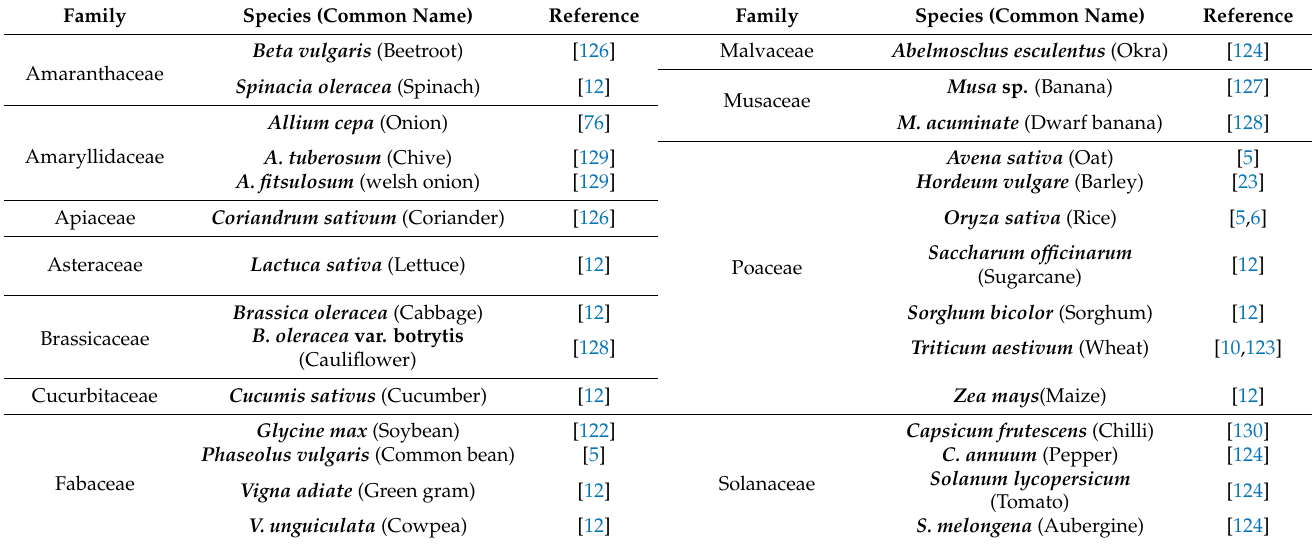
Table 2. Cultivated hosts of Meloidogyne